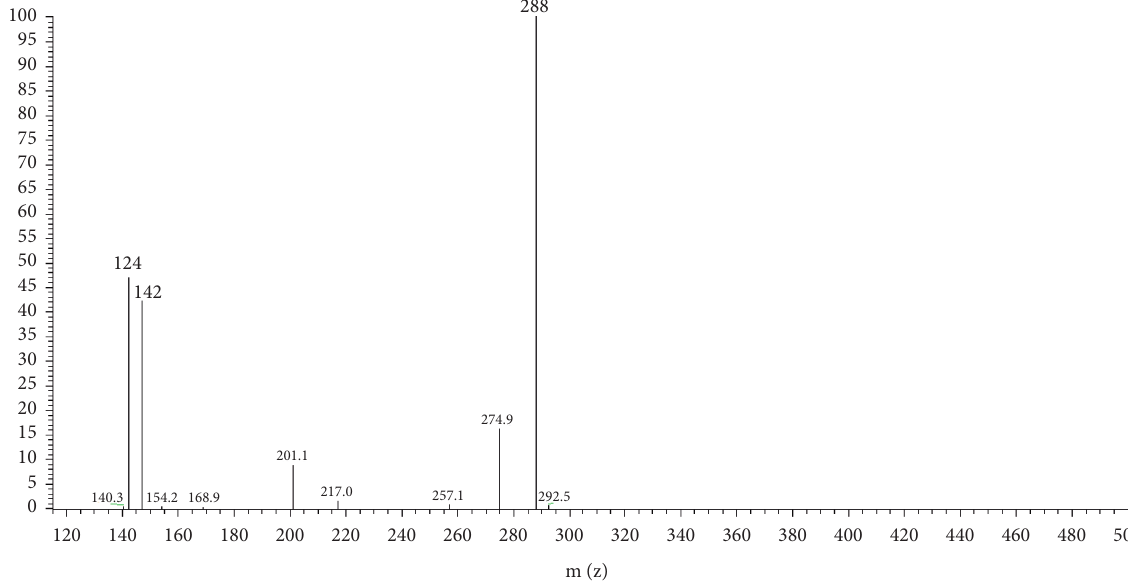
Figure 6: MS2 spectrum of compounds 26 and 34, probable new